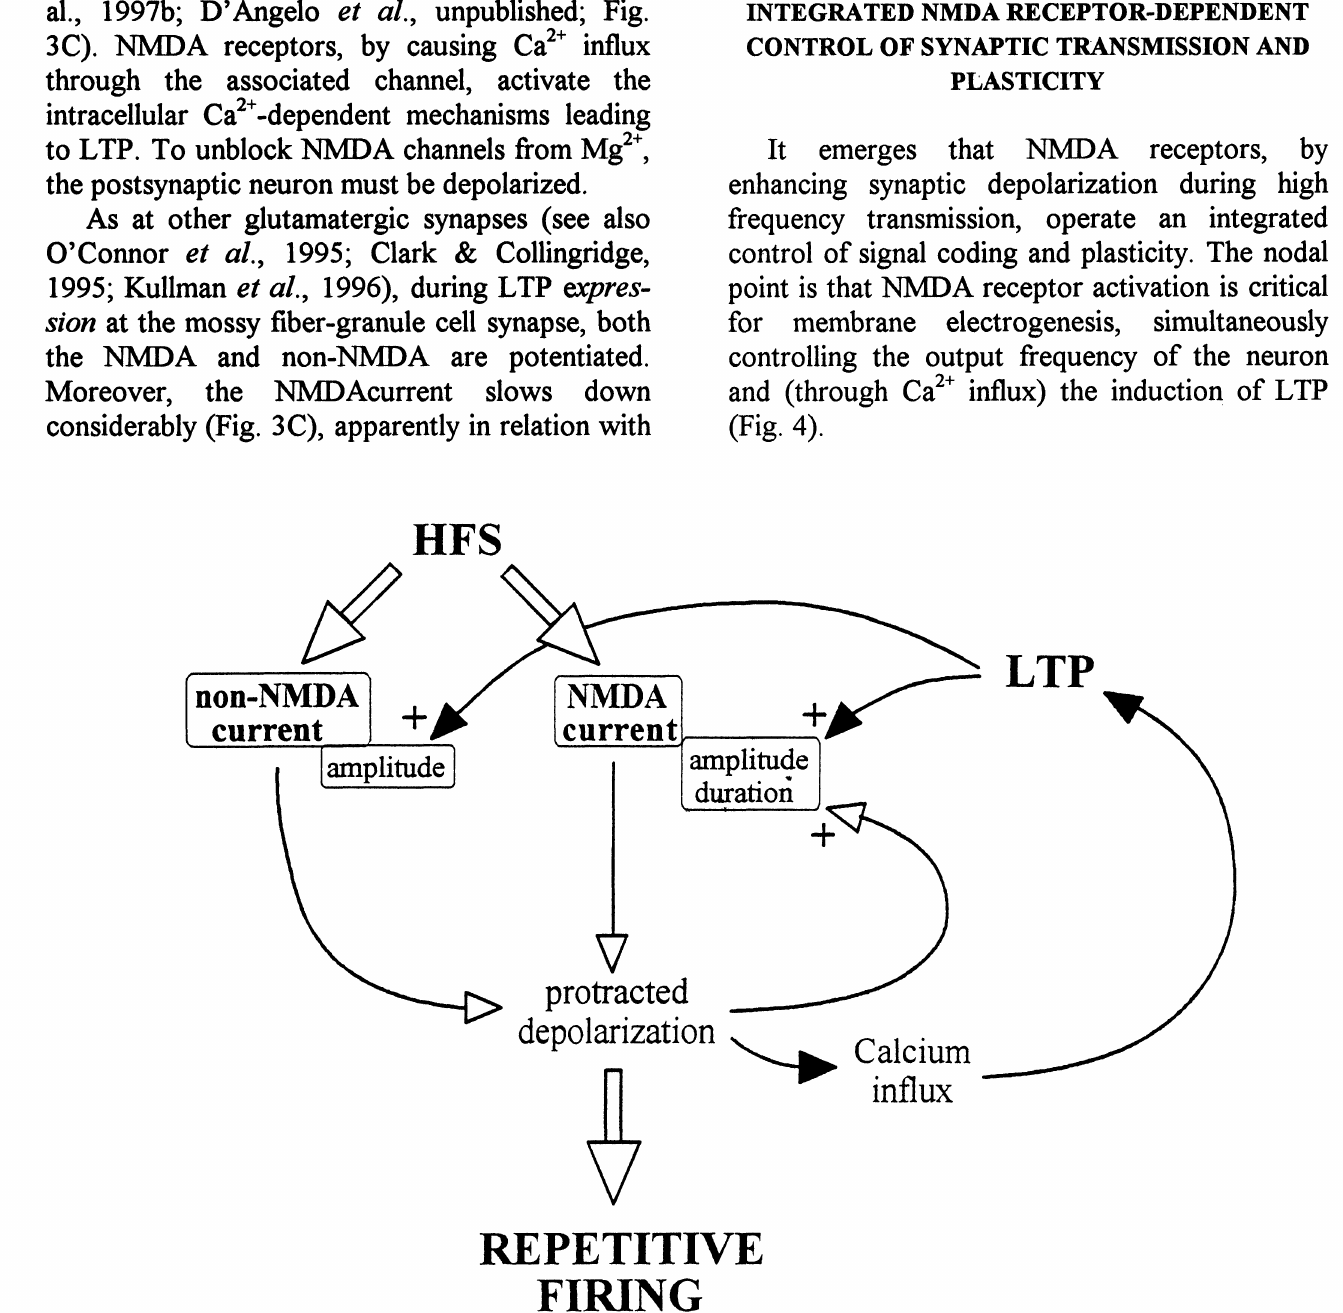
Fig. 4: Integrated regulation of signal coding and plasticity by NMDA receptors. In this model, NMDA-receptor activation is critical for both membrane electrogenesis and Ca / influx. At the core of this process remains a voltage-dependent increase in size and duration of the NMDA current during membrane depolarization, with non-NMDA receptors priming the regenerative process. The NMDA receptors, by increasing their own responsiveness, configure the system in feed-forward mode. Note that the final effect will be an enhancement of repetitive firing, and therefore of the input-output function of the